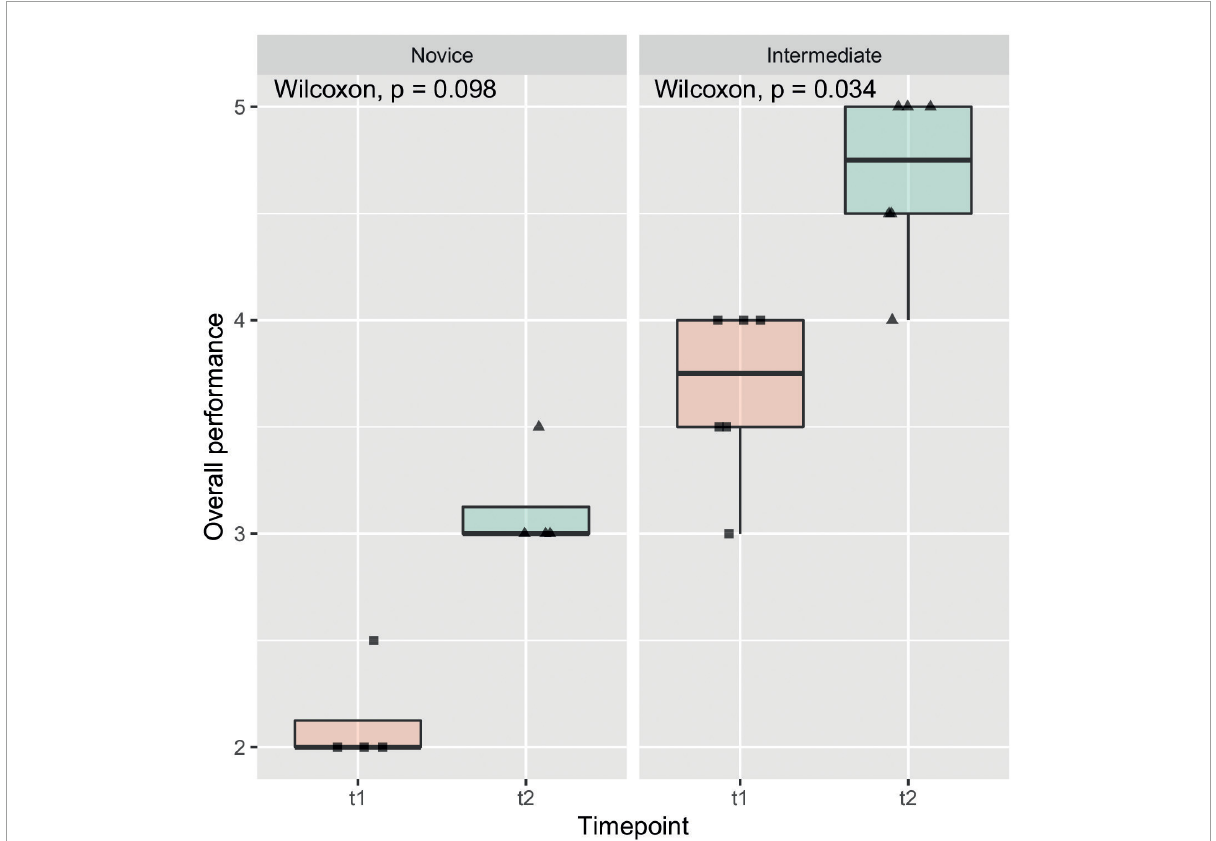
FIGURE5 Overall performance subgroup analysis: In this box plot, which shows the same data as in this figure, subgroup analysis by experience of participants was performed. Observed increase in overall performance seemed to have been more pronounced in intermediate participants compared to novice